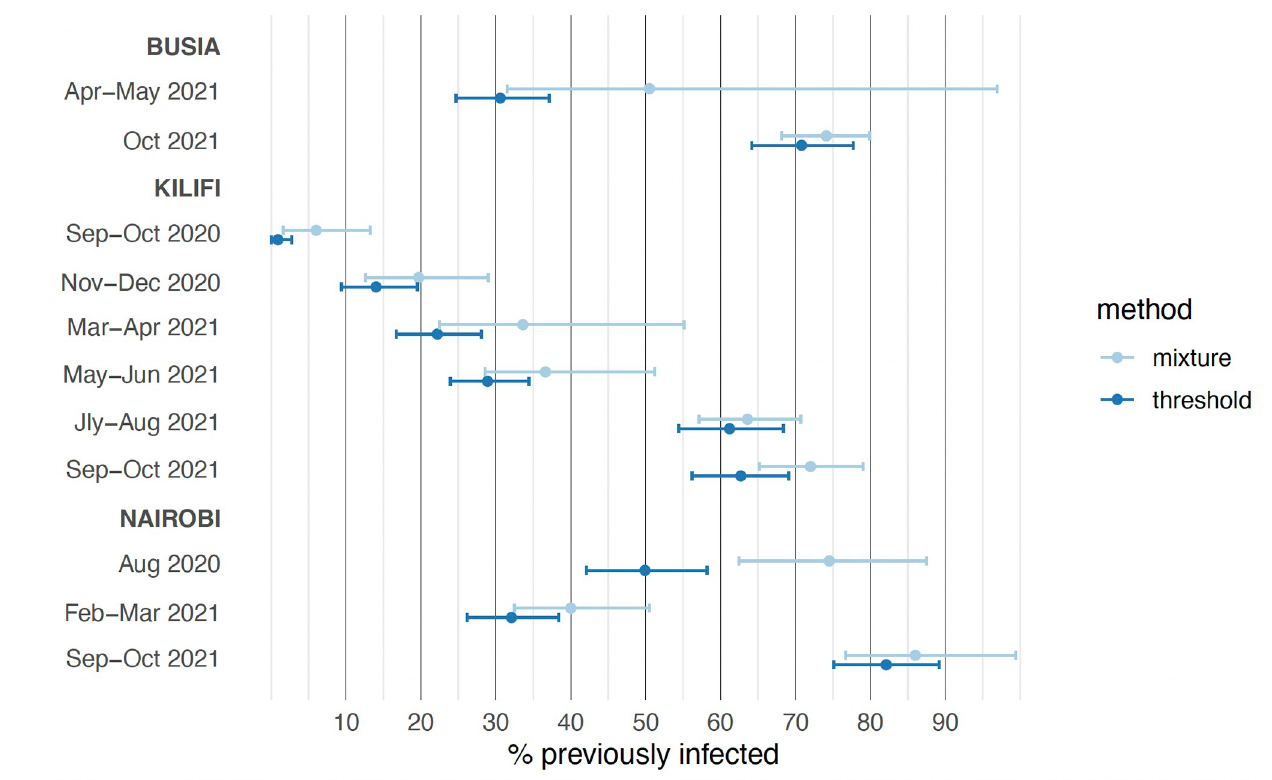
Fig 2. Adjusted and modelled estimates of the cumulative incidence of SARS-CoV-2 infection. Estimates are shown with 95% credible intervals.